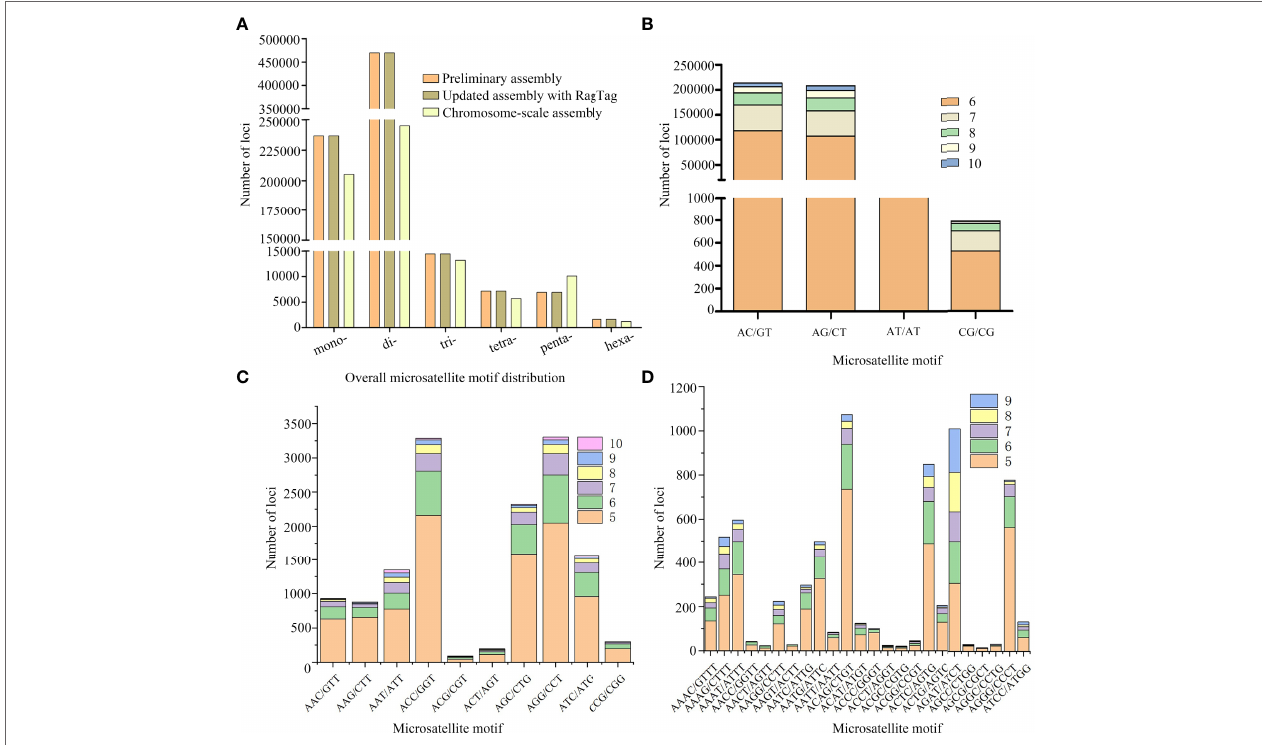
FIGURE 2 | Distribution and frequency of microsatellite loci in Chiloscyllium plagiosum. (A) Frequency of different microsatellite repeat types in three genome assemblies. (B–D) Frequency of dinucleotide, trinucleotide, and tetranucleotide microsatellite motifs in our